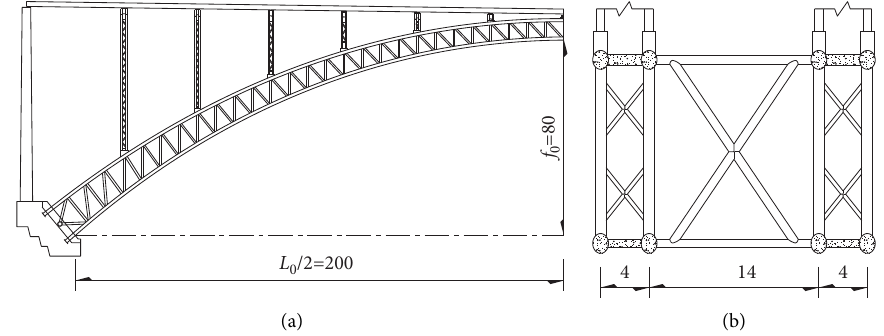
Figure 1: Main bridge structure layout (unit: m). (a) Half main bridge facade. (b) Typical cross-section of main arch ring.